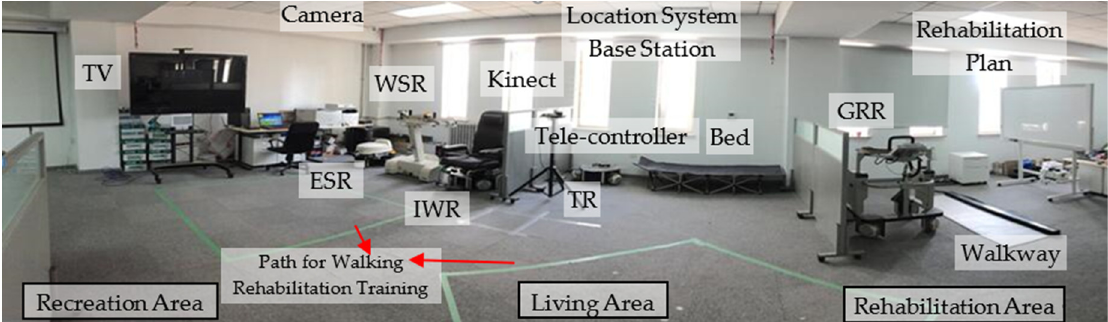
Figure 1. The smart house based on multiple welfare-robots.